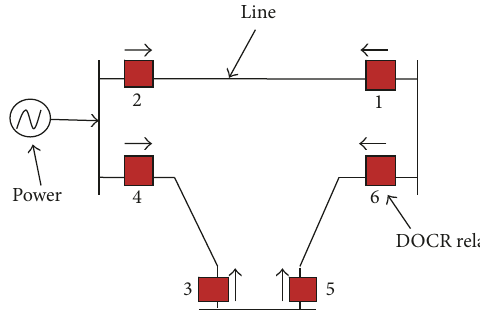
Figure 8: Model for the IEEE 3-bus